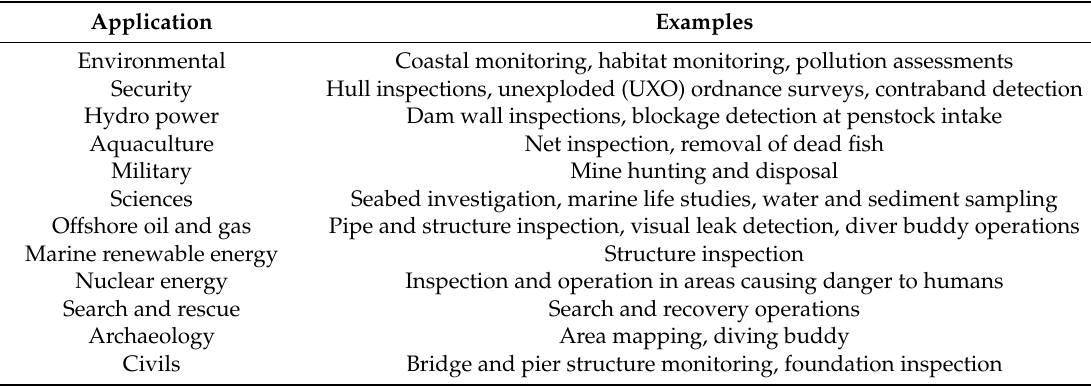
Table 1. Sample applications for inspection-class Remotely Operated Vehicles